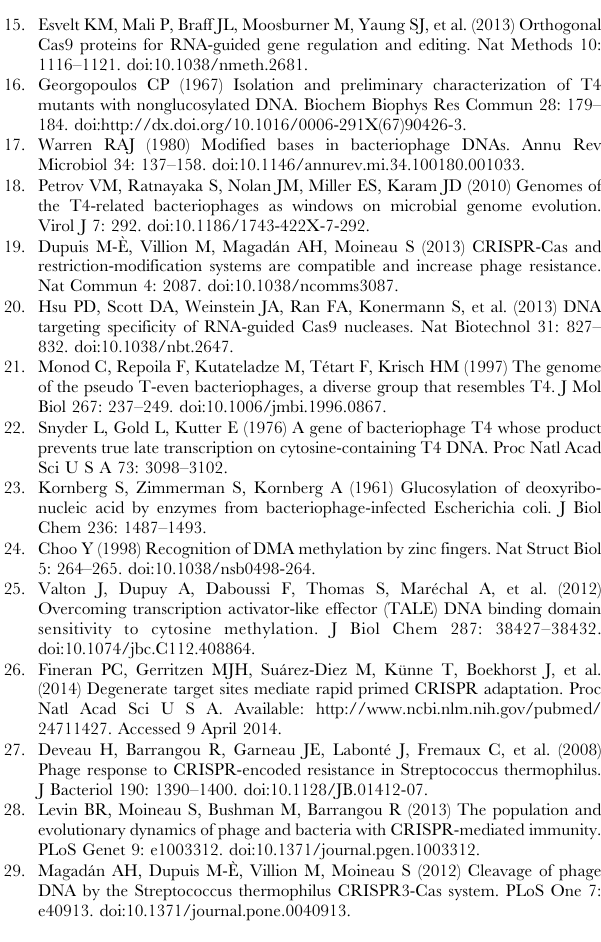
Figure S1 Restriction digest of phages. Phage DNA was extracted by using the Qiagen Blood and Tissue Kit on 200 m L of phage stock. 10 or 20 U of each enzyme (1 m L) was added to 5 m L of 10X CutSmart Buffer (NEB) in a 50 m L reaction volume containing approximately 100 ng of phage RB49 or T4 DNA, or 800 ng of T4 gt DNA. The reactions were incubated at 37 u C for 4 hours before visualizing on a 1% agarose gel stained with SYBR Gold. As expected, DraI cuts all RB49, T4 gt, and T4; HpaII and NheI are sensitive to methylated cytosines and only cut RB49; and